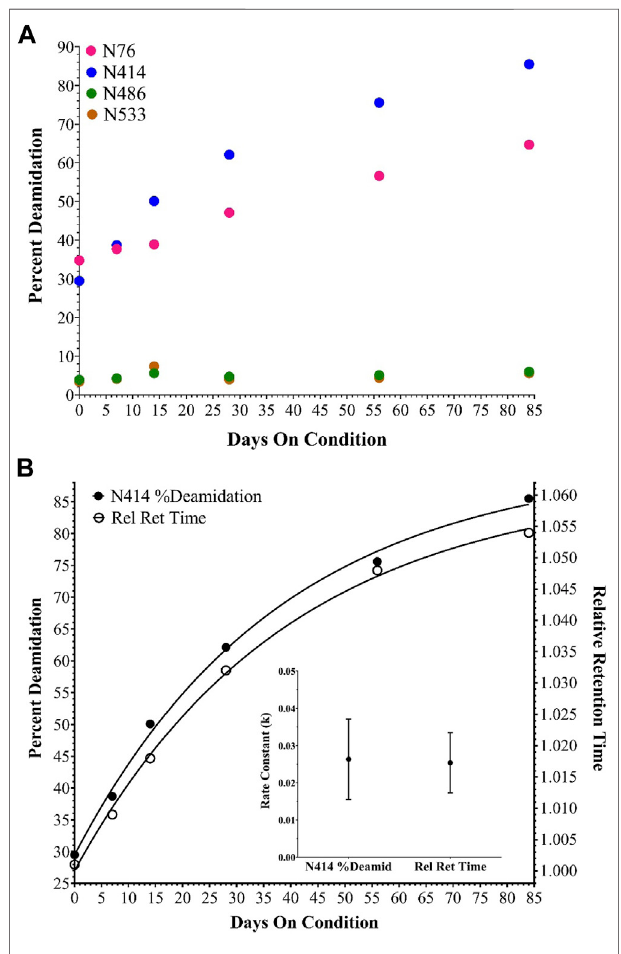
FIGURE 3 | Deamidation of selected hexon asparagine residues during the accelerated stability time course. (A) shows percent deamidation determined for N76, 414, 486 and 533 in AdC68 #1. (B) shows percent deamidation for N414 and the AEX-HPLC relative retention time shift both fi t to a single exponential equation [Y=Y0 + (Plateau-Y0)*(1-exp (-K*x)], the calculated rate constants and the associated error for AdC68 #1.